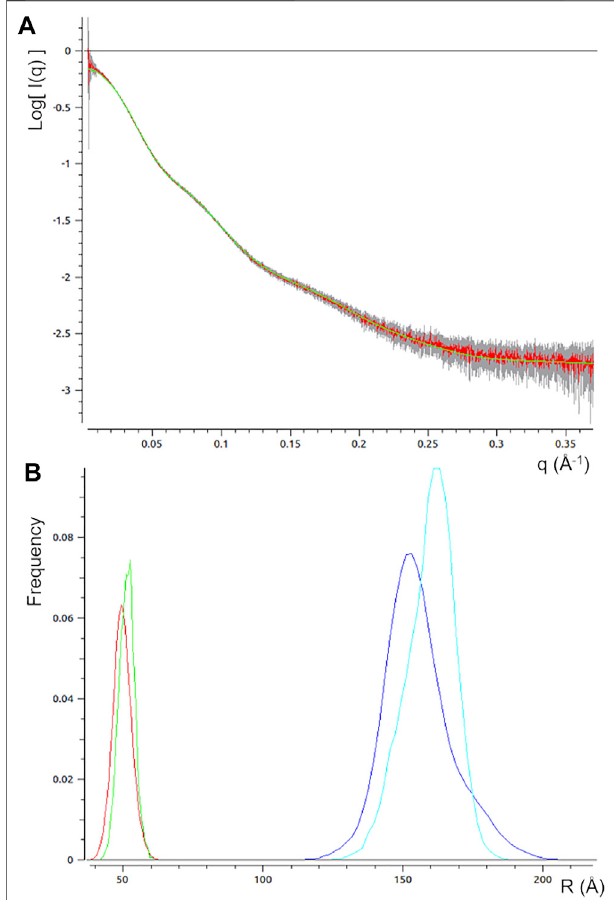
FIGURE 6 | Results of the modelling procedure based on the ensemble optimization method. (A) best fi t of the calculated SAXS pro fi le (green line) vs the observed one (red line, experimental error bars in grey); (B) distribution of the radius of gyration ( R g ) and the maximum interatomic distance ( D max ) values for the selected models (green and cyan lines, respectively) and initial pool of random mAb structures (red and blue lines,